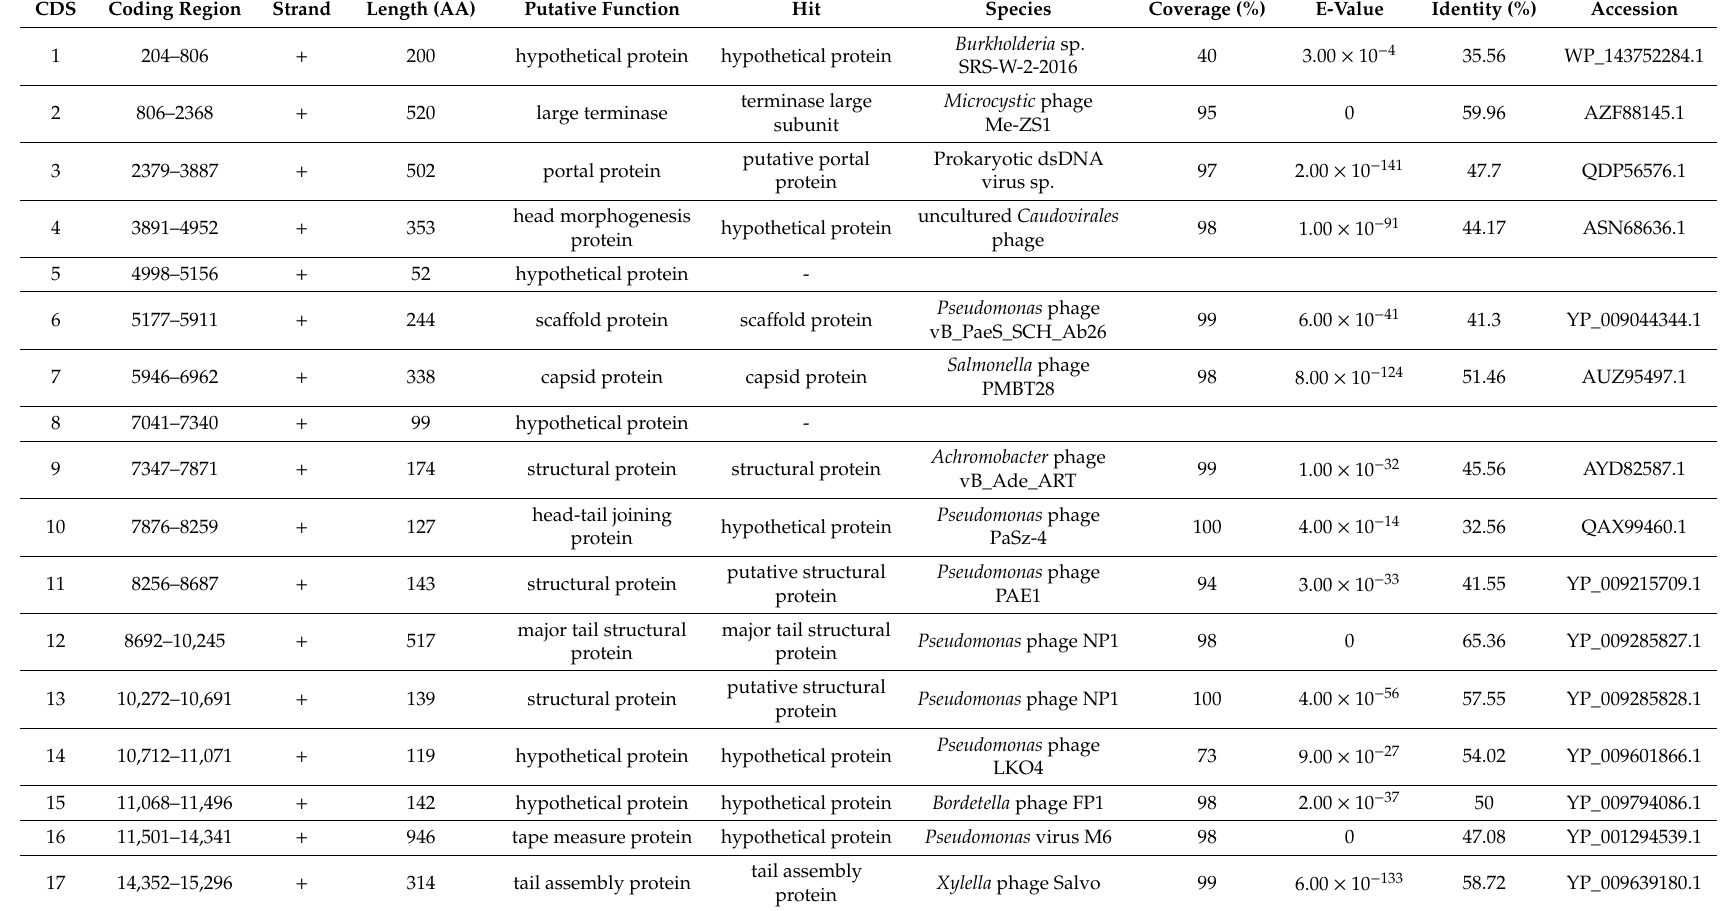
Table 2. Genome annotations for AXL3 obtained from BLASTp and CD-Search data. Results below 1.00 × 10 − 3 were not recorded and the function was annotated as